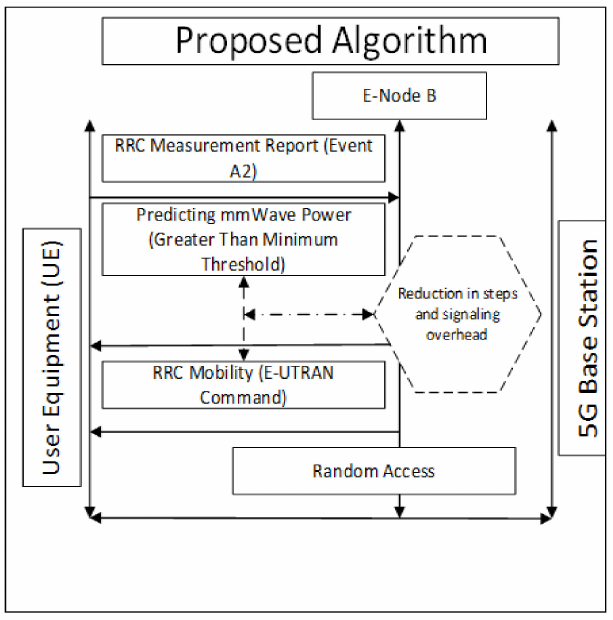
Figure 2. Proposed algorithm for handover (reduced steps and signaling overhead